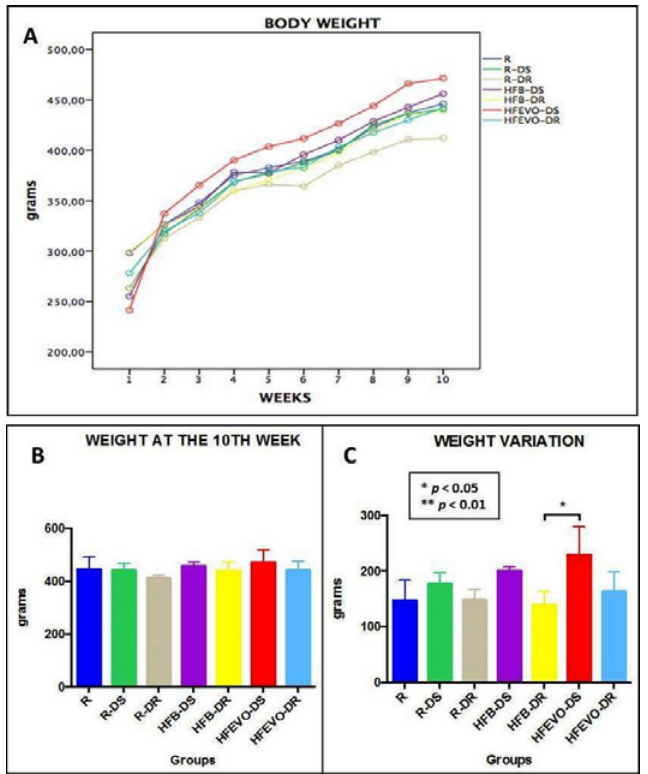
Figure 1. Graphs: ( A ) and ( B ): body weight over 10 weeks, the differences between groups were not significant ( p > 0.05). ( C ): body weight variation over 10 weeks, a slight trend toward a greater weight gain in the DS experimental groups is evident; the only statistically significant difference was between HFB ‐ DR and HFEVO ‐ DS ( p < 0.05). R: Regular diet; R ‐ DS: Regular diet with vitamin D